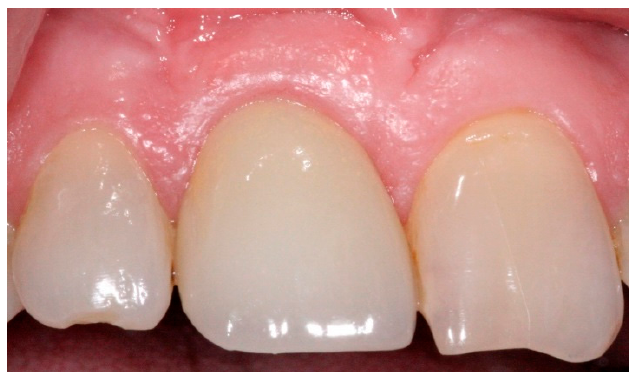
Figure 10. Conventional die for implant abutment supported crown fabrication.